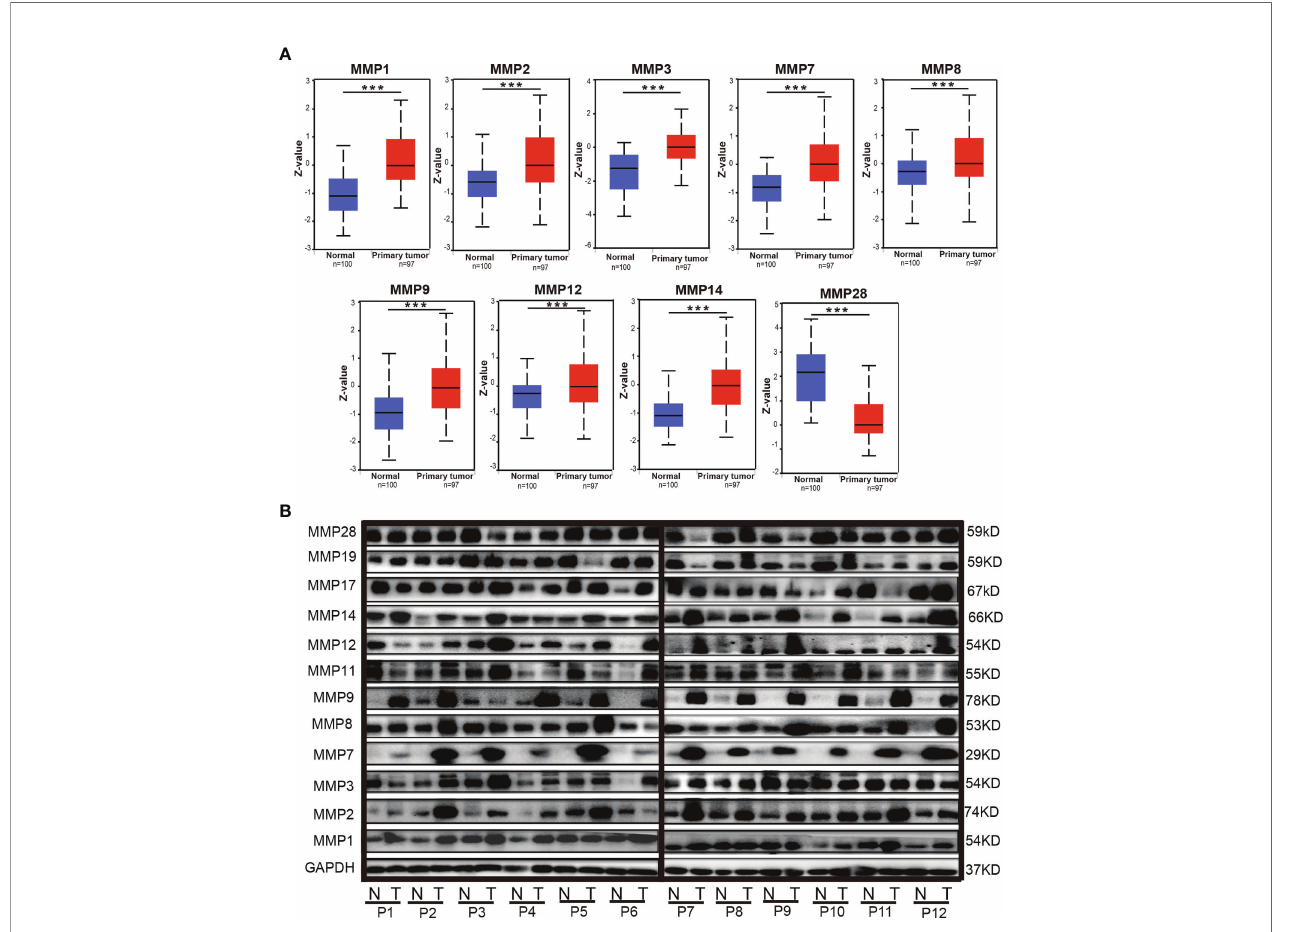
FIGURE 4 | The protein levels of MMPs in colorectal cancer tissue and normal tissue. (A) The protein levels of MMPs in UALCAN database; signi fi cant records are denoted by the red asterisk on top of the boxplot (*** p < 0.001). (B) The protein levels of MMPs in our 12 samples, which were measured by Western blotting